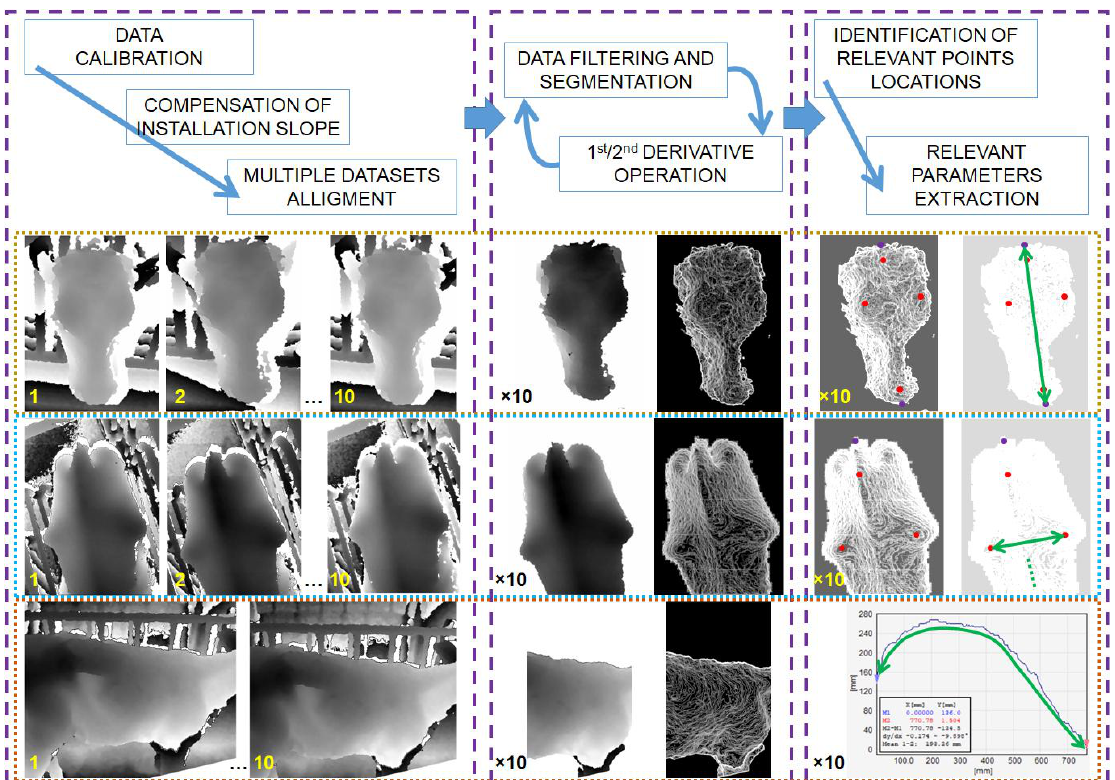
Figure 3. In the first row a flow chart representation of the applied methodology. In the bottom series of images three example of data extraction, respectively, for the head size, the hip distance, and chest girth, as indicated by green arrows.